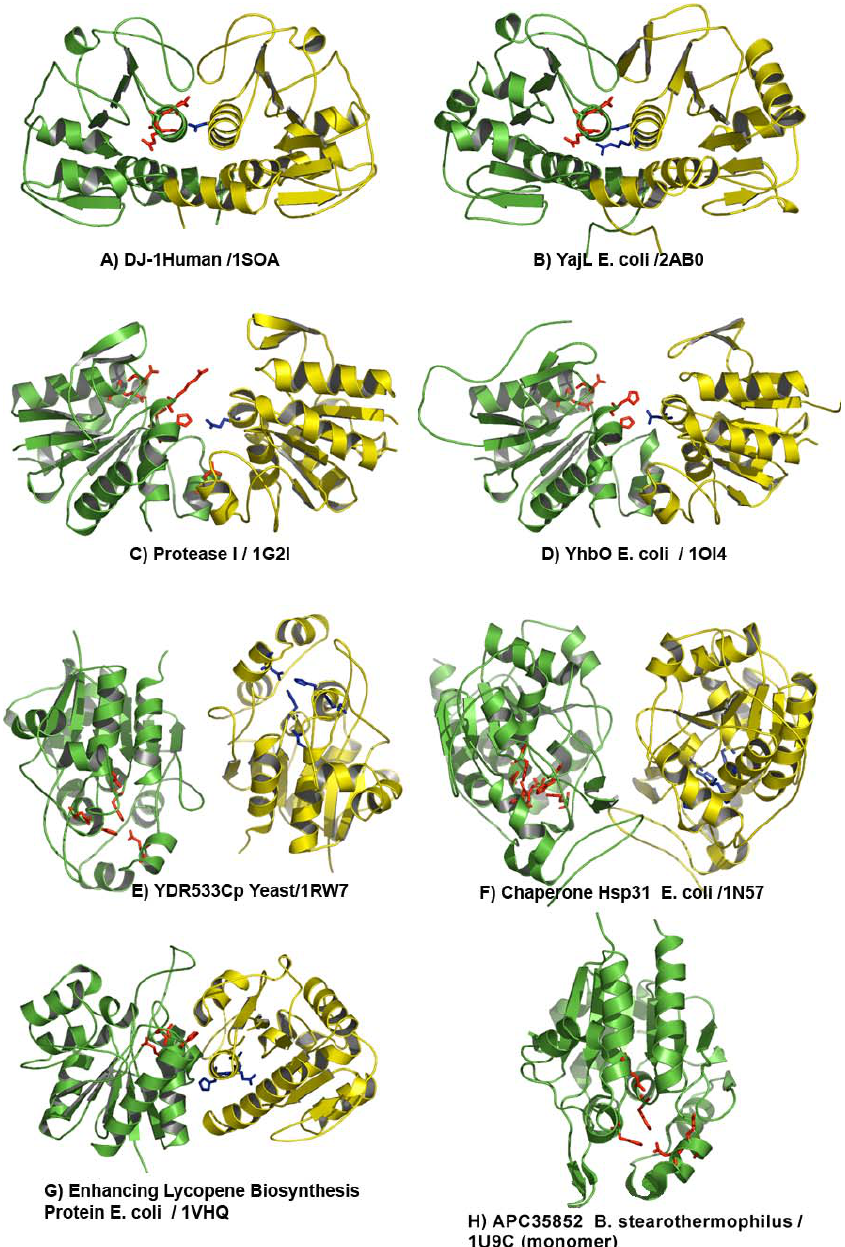
Figure 2. Ribbon Diagrams of Eight DJ-1 Family Proteins with Predicted Active Sites (A) Human DJ-1; (B) YajL E. coli; (C) Protease I P. horikoshii; (D) YhbO E. coli; (E) YDR533Cp yeast; (F) Chaperone Hsp31 E. coli; (G) putative Enhancing lycopene biosynthesis protein E. coli; (H) APC35852 B. stearothermophilus . The subunit backbones are shown in yellow and green. Residues predicted by THEMATICS to be active site residues are shown in red (from the green subunit) and blue (from the yellow subunit).